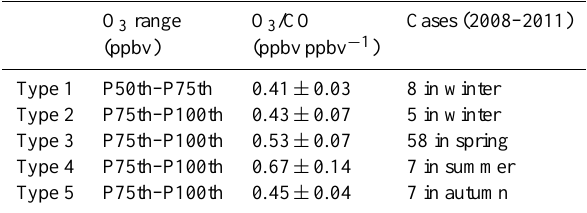
Table 5. O 3 /CO ratios at IZO for events with hourly O 3 -CO data correlation r > 0 .